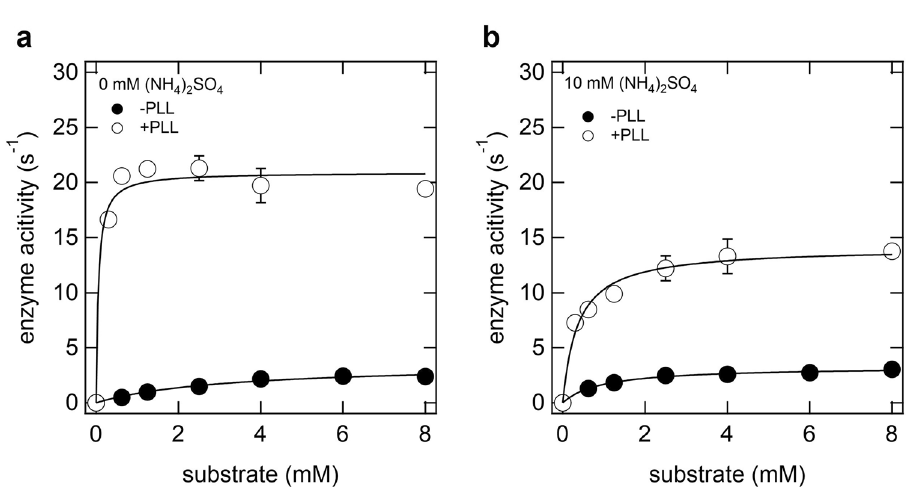
Figure 4. Enzyme kinetics of LOX in clusters lox . ( a ) and droplets ( b ). The sample solution contained 0.1 µM LOX, 0 or 0.02 mM PLL, 0–8 mM L-lactic acid, 20 mM Tris–HCl (pH 8), and 0 or 10 mM (NH 4 ) 2 SO 4 .